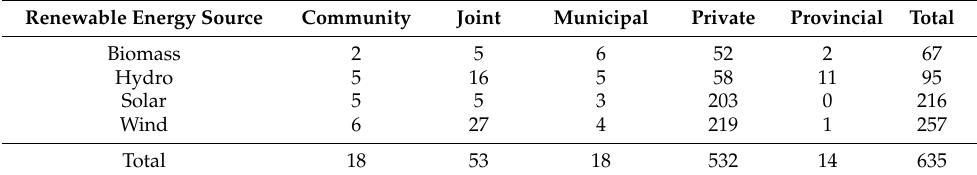
Table 3. Categories of in-operation renewable energy projects between 2010 and 2021